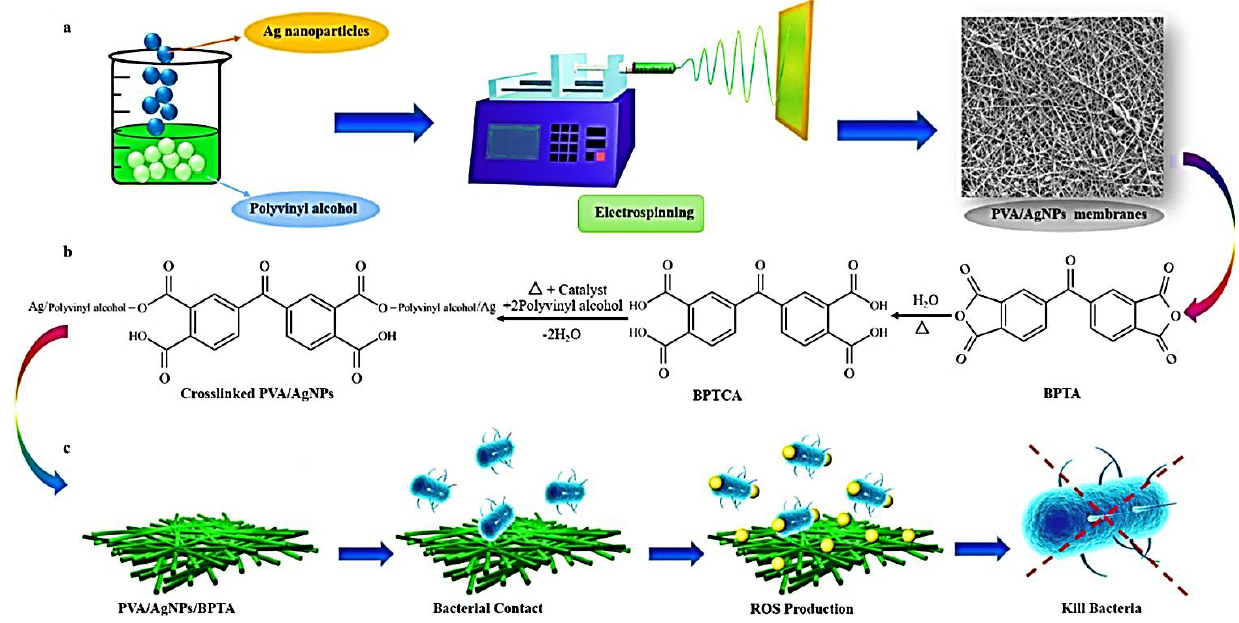
Figure 11. Polymer poly(vinyl alcohol)/silver nanoparticle-based nanocomposite membrane for air fil- tration [207]. PVA/AgNP = poly(vinyl alcohol)/silver nanoparticle; BPTA = 3,3′,4,4′ -benzophenone tetracarboxylic acid; PVA/AgNP/BPTA = poly(vinyl alcohol)/silver nanoparticle/3,3′,4,4′ -benzophenone tetracarboxylic acid; ROS = reactive oxygen species. Reproduced with permission from Elsevier.